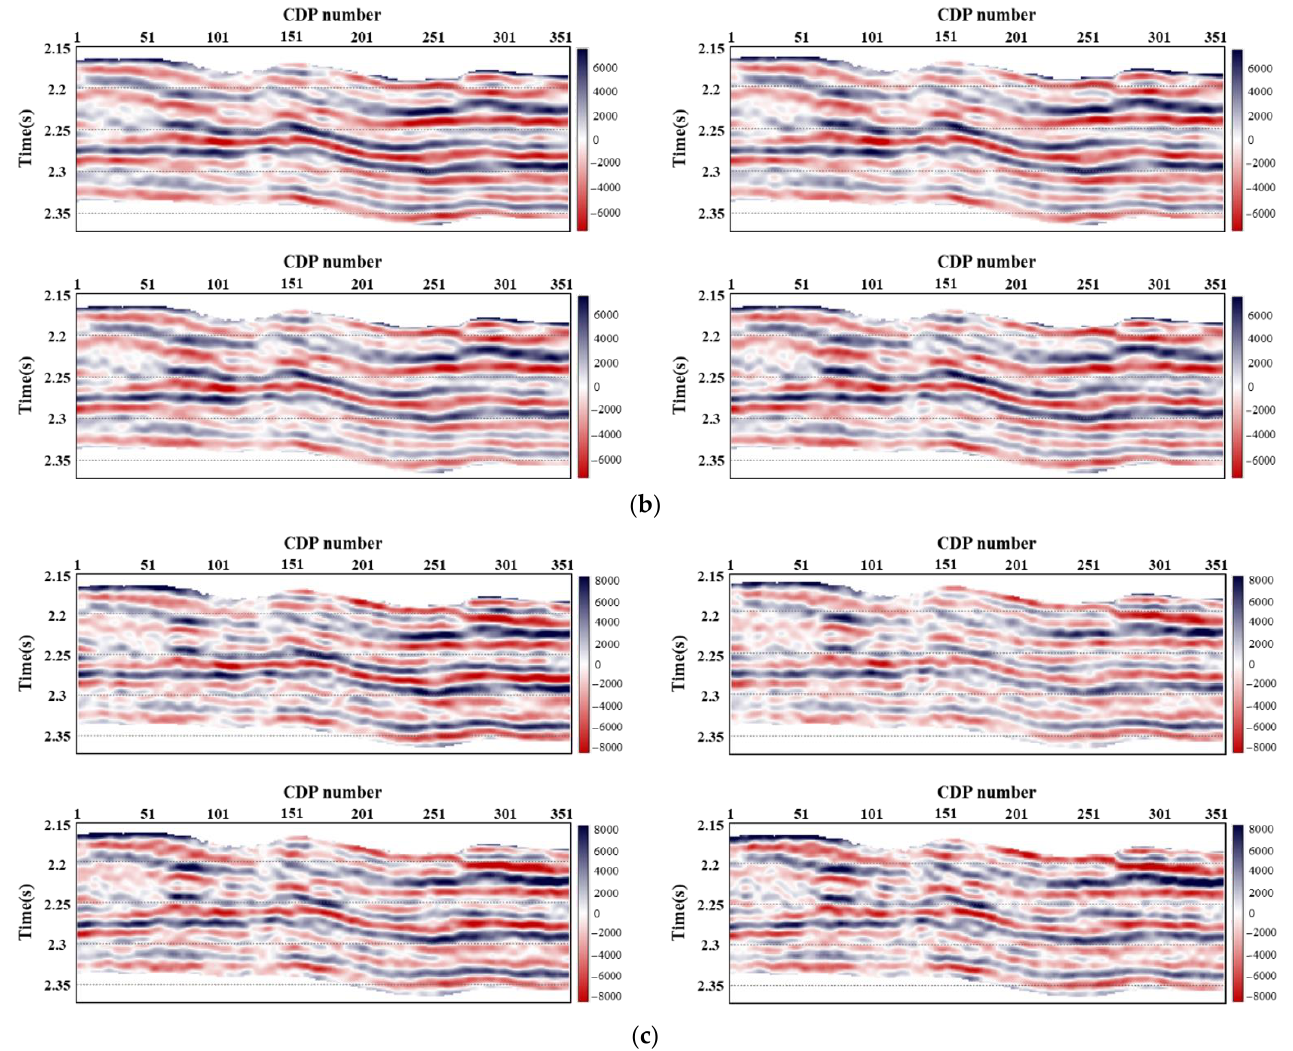
Figure 7. Different angles of seismic data for four azimuths: ( a ) small angle; ( b ) middle angle; ( c ) large angle.